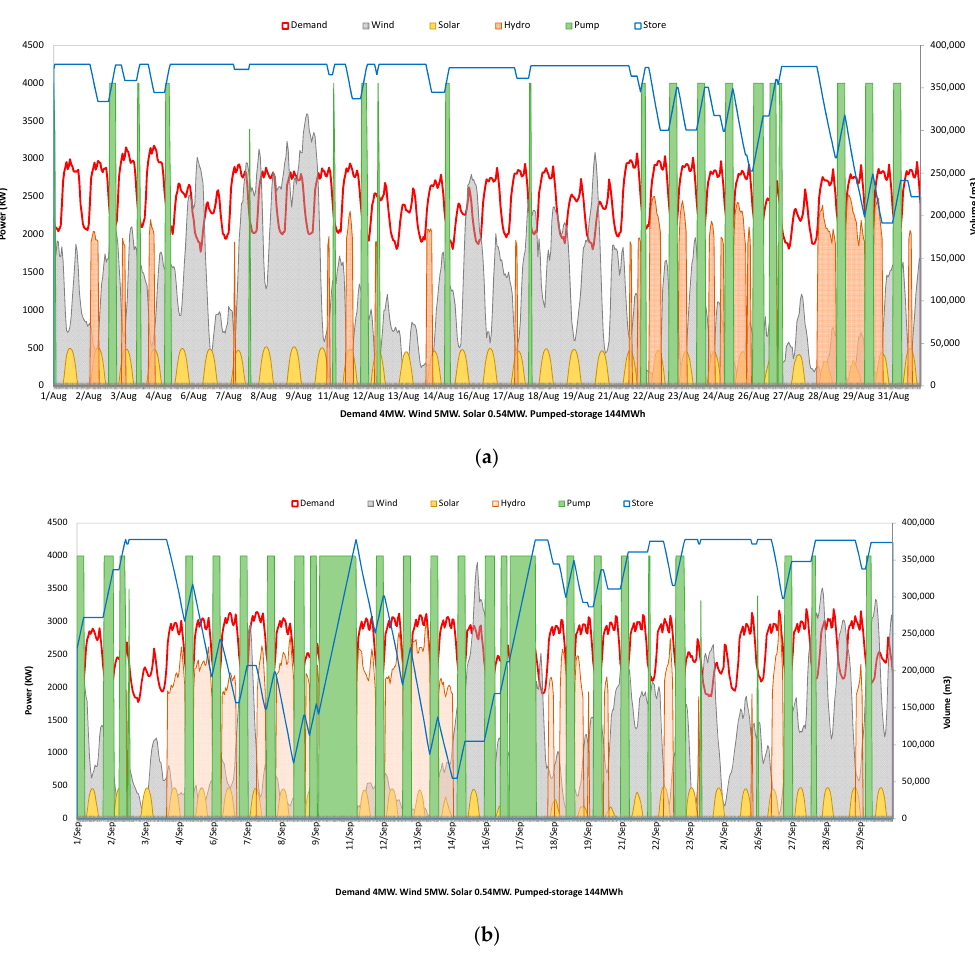
Figure 10. Electricity generation and stored in scenario 2 between August ( a ) and September ( b ). It is notable that increasing the wind power, the hydropower production decreases accordingly.